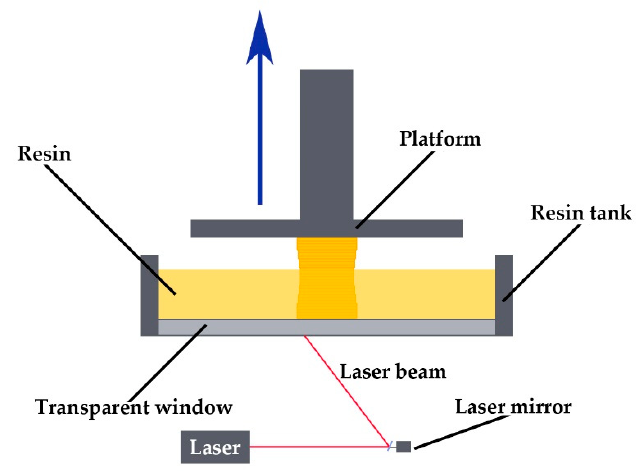
Figure 8. The diagram of the SLA process.